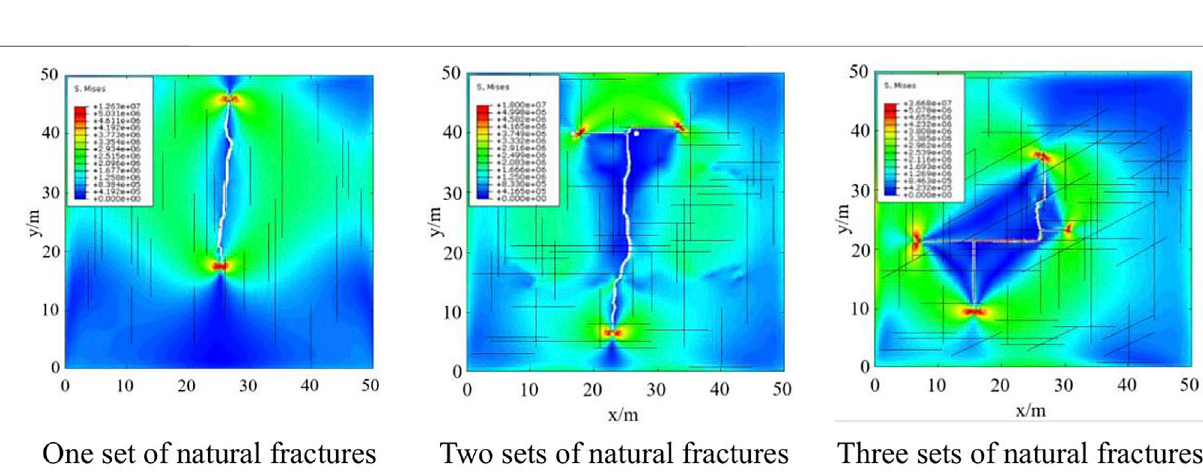
Frontiers in Earth Science |